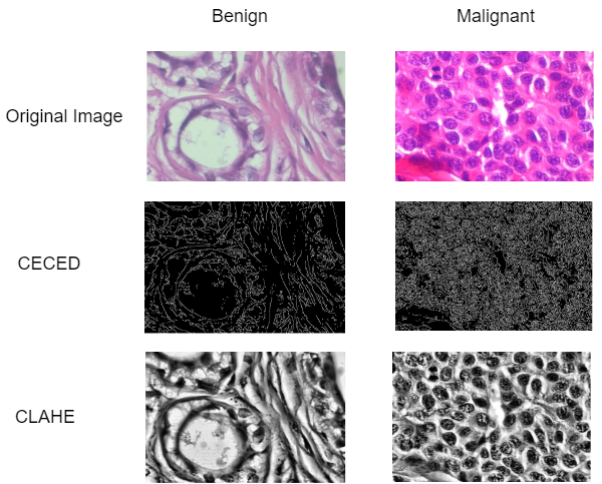
Figure 2. Histopathological breast cancer images. The first row represents the original images. The second row depicts the edge detected images. The third row presents the contrast-enhanced